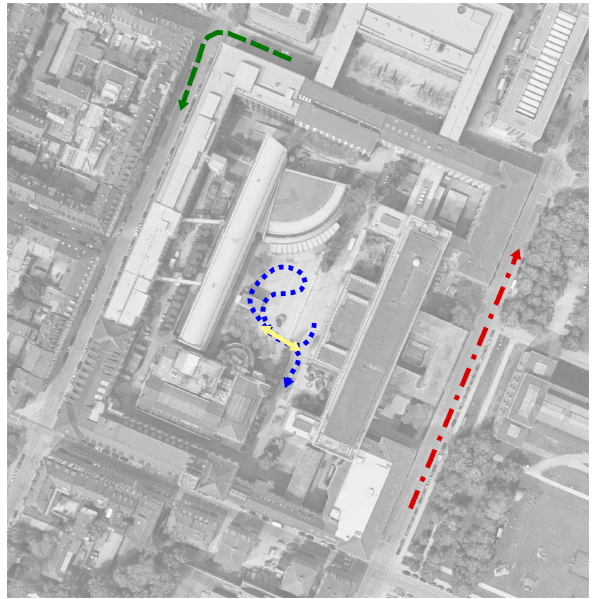
Figure 1. Overview of the trajectories. Uni-directional trajectory (dash-dotted red line), ortho-directional trajectory (dashed green line), bi-directional trajectory (solid yellow line), multi-directional trajectory (dotted blue line). We determine the relative orientation four times each time based on a different trajectory. The trajectories are depicted in Figure 1. The first one represents a uni-directional trajectory (dash-dotted red line) like driving straight along the road. We call the second one ortho-directional trajectory (dashed green line). This trajectory is typical for turning a right-angled corner. The third one represents a bi-directional trajectory (solid yellow line) like driving the same road back and forth. The fourth one is a multi-directional trajectory (dotted blue line) like for turning around at a confined space. The bi-directional and the multi-directional trajectory, moreover, contain a ramp so that the height of the laser scanner w.r.t. the ground changes. All